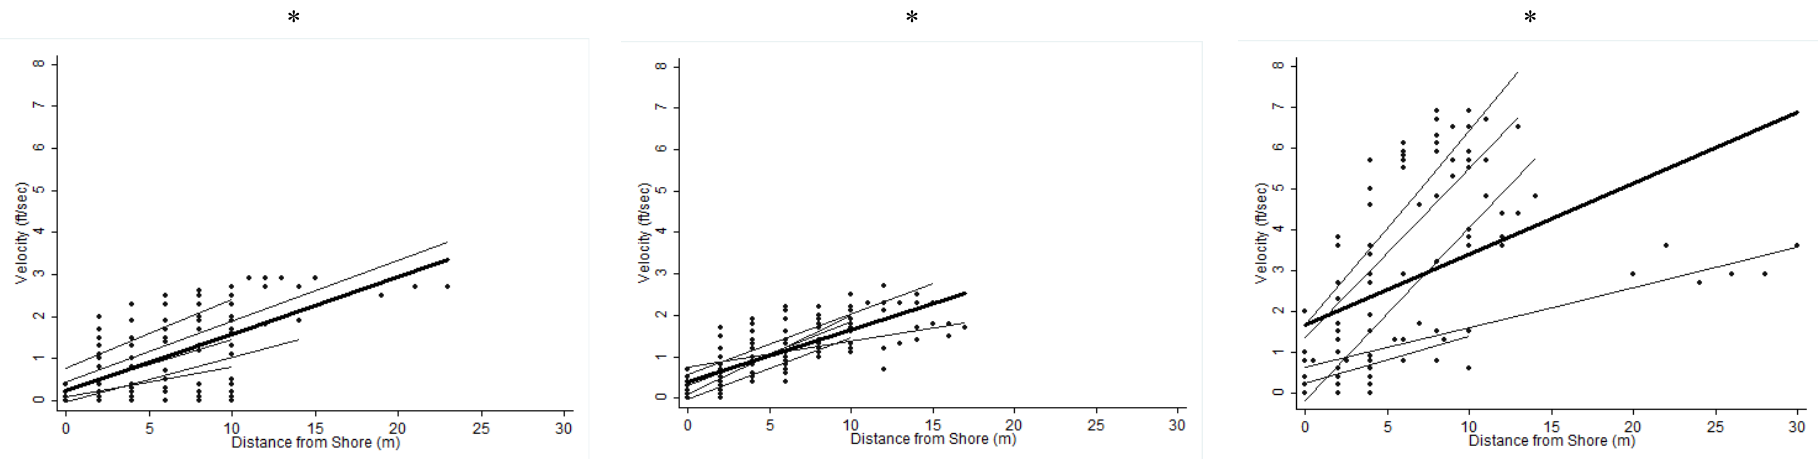
Figure S1. Overall trend of water quality variables compared to distance from shore. Best-fit lines are shown for each transect (light grey) and for each river (black). * Significant at the 95% confidence interval